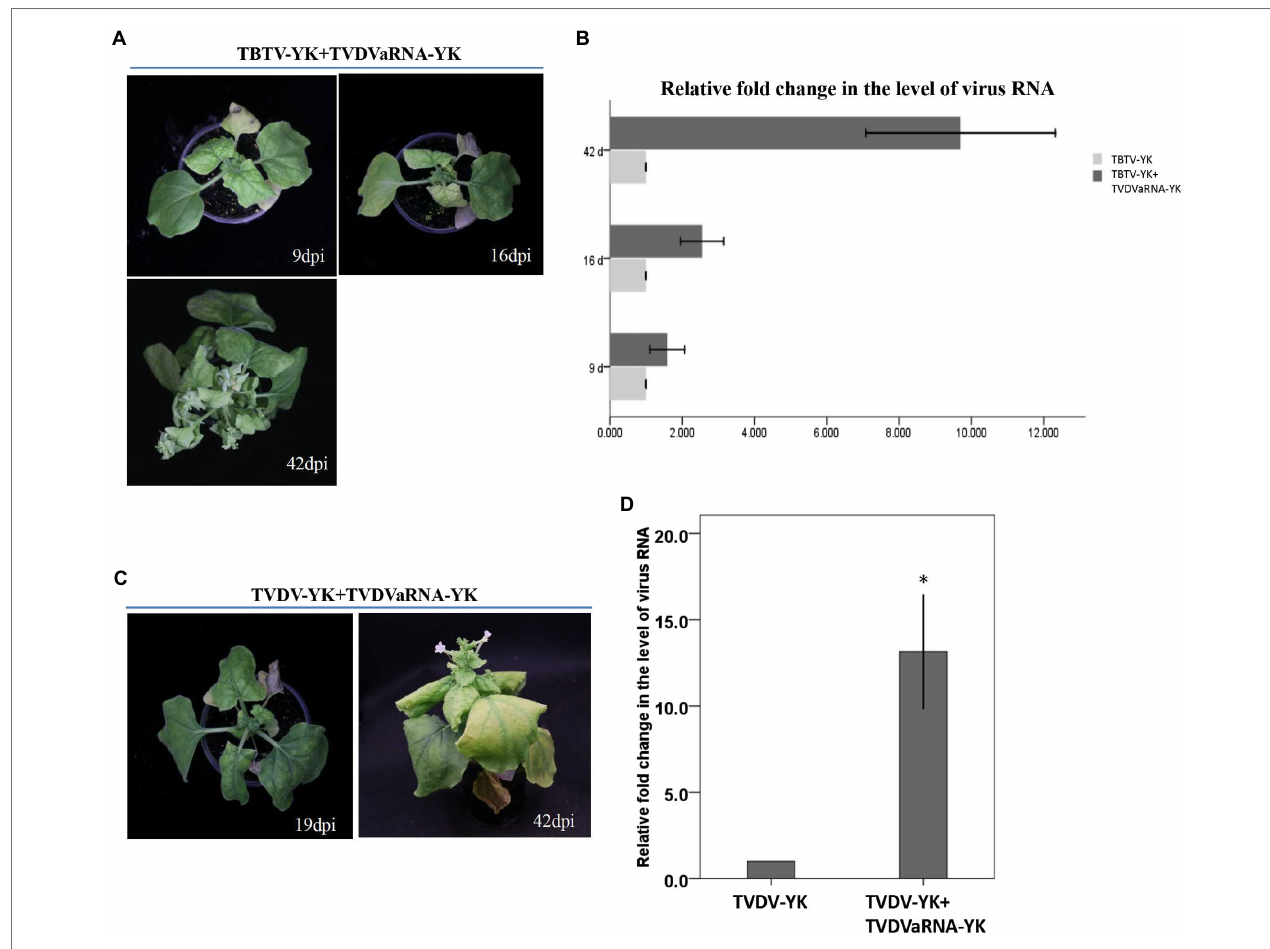
FIGURE 7 | Symptoms caused by TBTV-YK and TVDV-YK in Nicotiana benthamiana co-infected with TVDVaRNA-YK, and quantitative RT-PCR analyses of TBTV-YK and TVDV-YK RNA accumulations in the systemic leaves of Nicotiana benthamiana plants inoculated with TBTV-YK, TVDV-YK alone or with TVDVaRNA-YK. (A) Phenotypes of Nicotiana benthamiana plants inoculated with TBTV-YK+TVDVaRNA-YK via agro-infiltration. The plants were photographed at 9, 16, and 42 days postinoculation (dpi). (B) Quantitative RT-PCR analyses of TBTV-YK RNA accumulations in the systemic leaves of Nicotiana benthamiana plants inoculated with TBTV-YK alone or with TBTV-YK+TVDVaRNA-YK. The means ± SE were calculated using the data from three individual plants harvested at 9, 16, and 42 dpi. (C) Phenotypes of Nicotiana benthamiana plants inoculated with TVDV-YK+TVDVaRNA-YK via agro- infiltration. The plants were photographed at 19 and 42 dpi. (D) Quantitative RT-PCR analyses of TVDV-YK RNA accumulations in the systemic leaves of Nicotiana benthamiana plants inoculated with TVDV-YK alone or with TVDV-YK+TVDVaRNA-YK. The means ± SE were calculated using the data from three individual plants harvested at 19